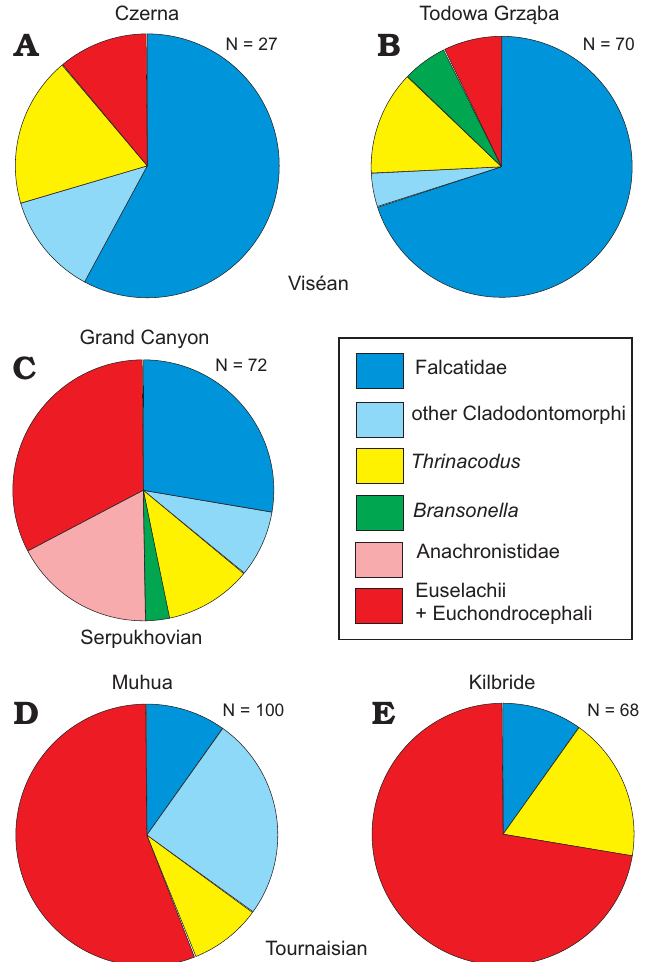
Fig. 8. Pie-diagrams illustrating relative abundances of teeth represent- ing groups of chondrichthyan taxa in five Mississippian